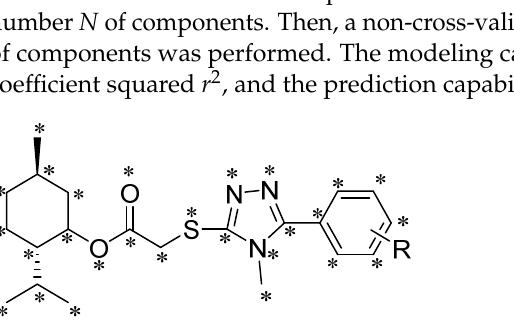
Figure 4. The asterisk skeleton of title compounds.